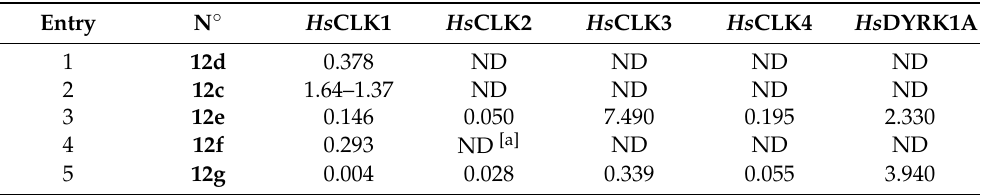
Table 2. IC 50 data ( µ M) for the inhibition of human kinases CLK1-4 and DYRK1A by the quinazo- lines 12 . Each concentration of compound was tested in